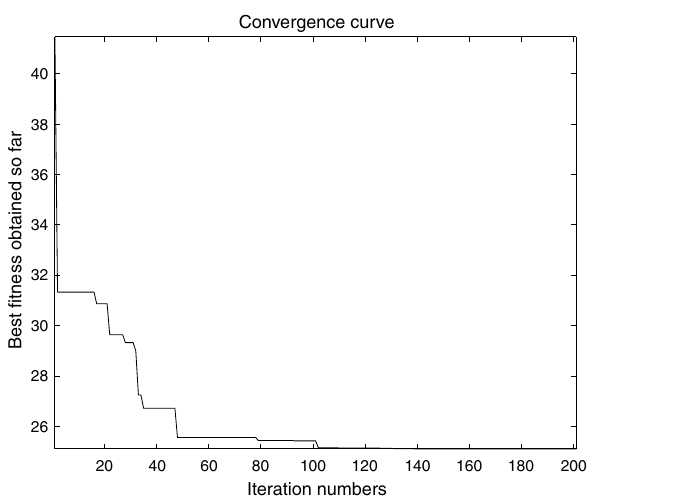
Figure 21. Convergence of tabular column.